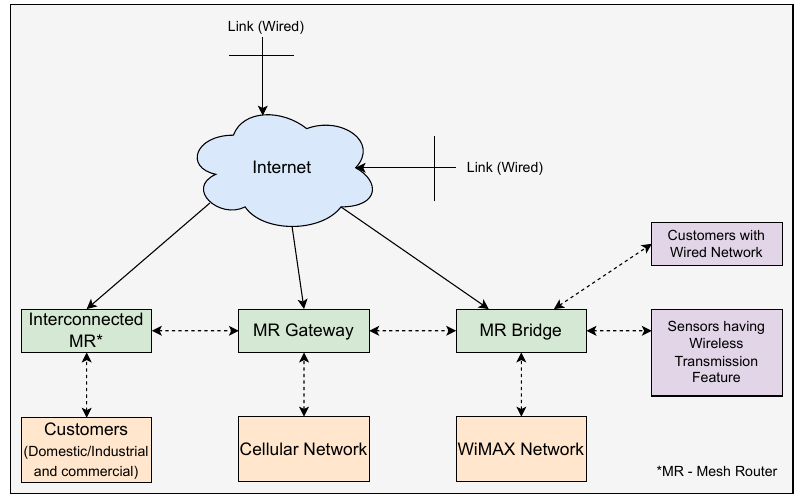
Figure 2. Architecture of wireless mesh